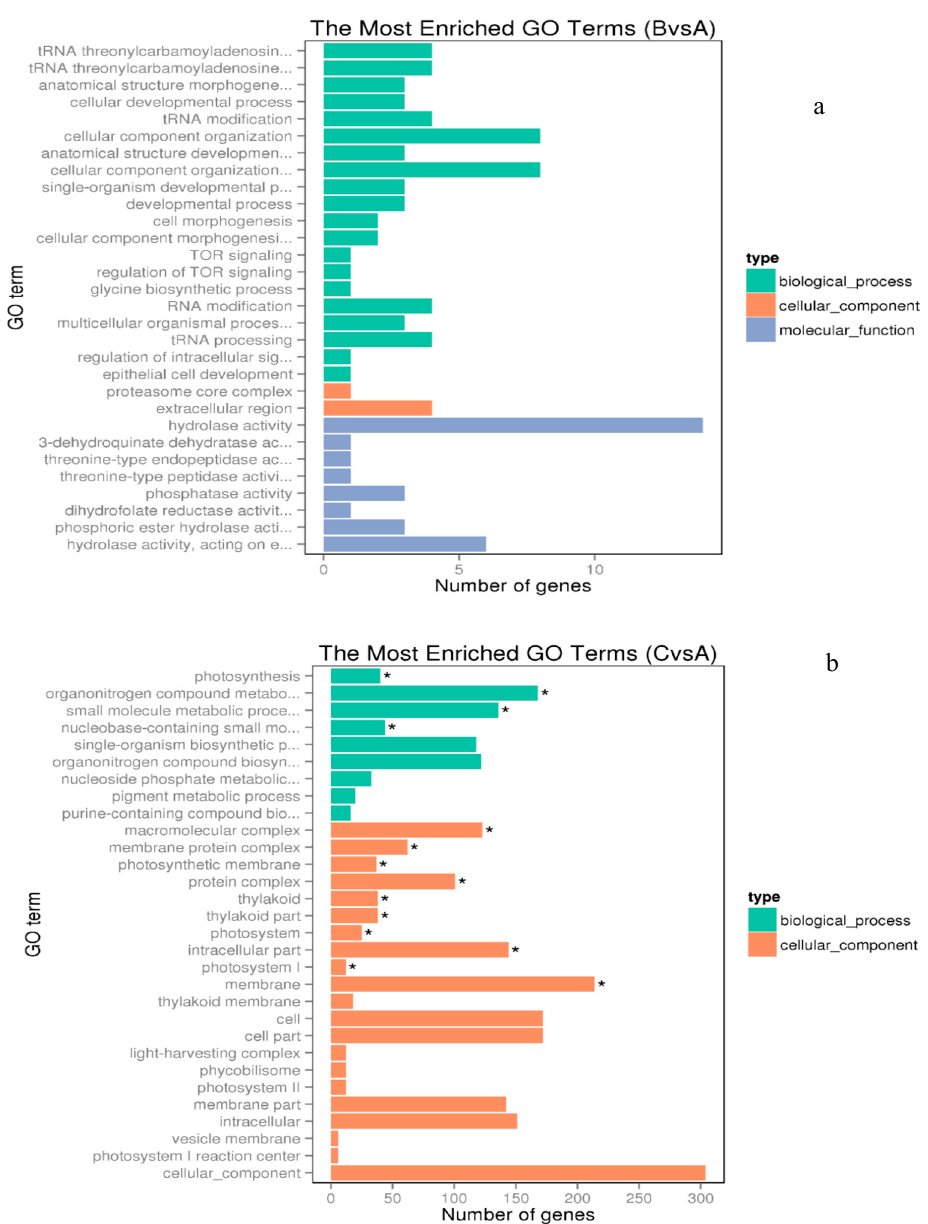
Figure 2. The significantly enriched Gene Ontology (GO) term of the 0.5 µM copper treatment group ( a ) and 3.0 µM copper treatment group ( b ). Green, orange and blue represent the enriched biological process, cellular component and molecular function. * represents significance at p < 0.05 between the copper-treated groups and the control group.